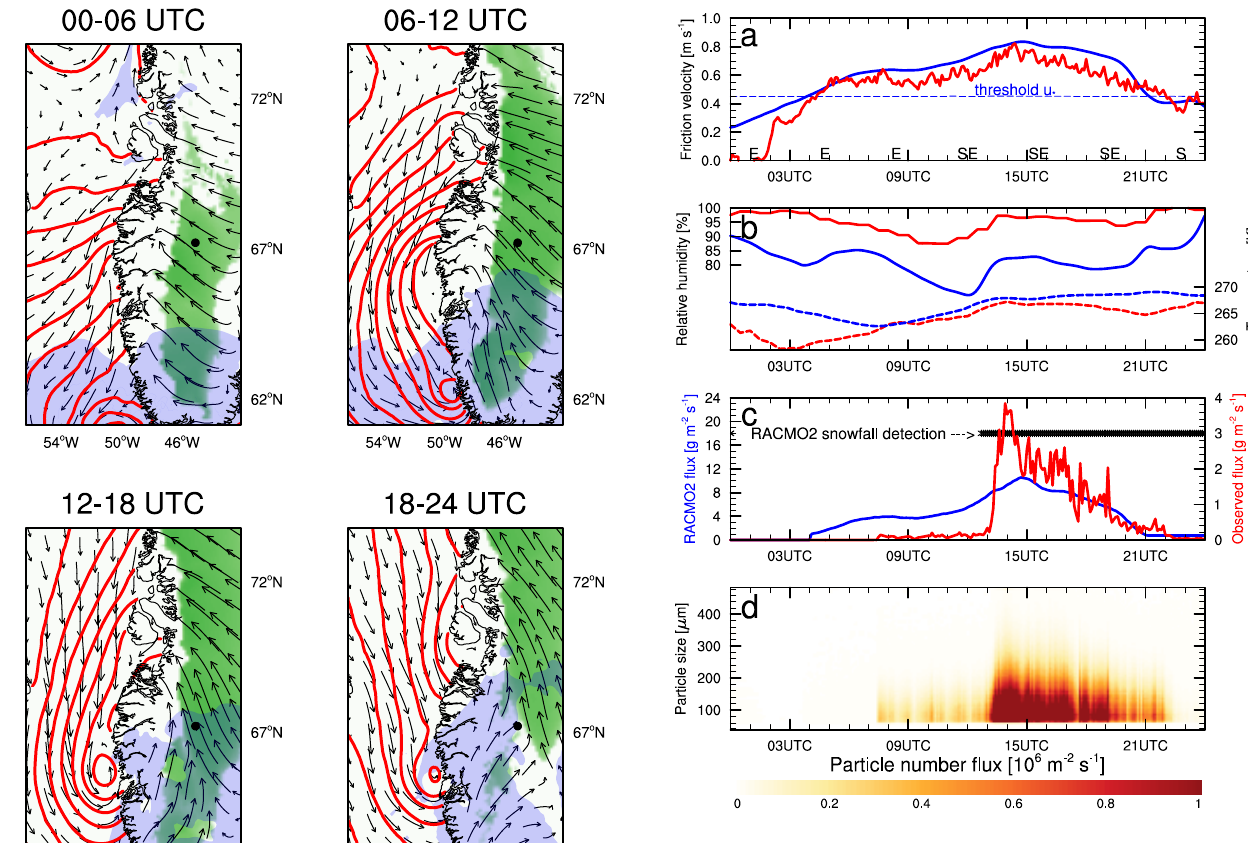
Fig. 12. Time evolution on 26 September 2012 of (a) observed (red) and simulated friction velocity (blue) and wind direction (indi- cated above bottom axis), and threshold friction velocity for drifting snow in RACMO2 (dashed blue); (b) observed (red) and simulated (blue) relative humidity (solid) and temperature (dashed) at ∼ 1m above the surface; (c) observed (red) and simulated (blue) drifting snow transport, with the observations originating from 1 level only, whereas RACMO2 snow transport is vertically integrated (mind the different units); and (d) observed number of snow particles per par- ticle size. The crosses in (c) indicate the occurrence of snowfall in RACMO2. Note that the label bar legend in (d) is increased by a factor of 10 compared to Fig.